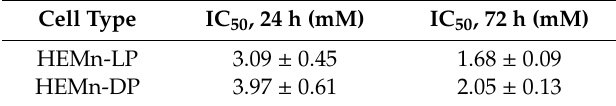
Table 1. Half maximal inhibitory concentration ( IC 50 ) values of NaF cytotoxicity assessed by MTS assay at 24 and 72 h in HEMn-LP and HEMn-DP cells. Values are mean ± SEM from three independent experiments ( n = 3).